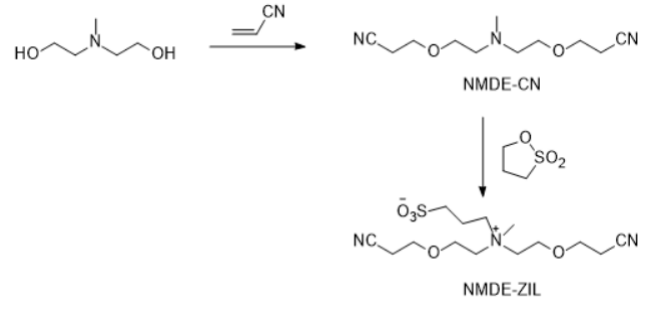
Figure 7. Synthesis of NMDE-ZIL.